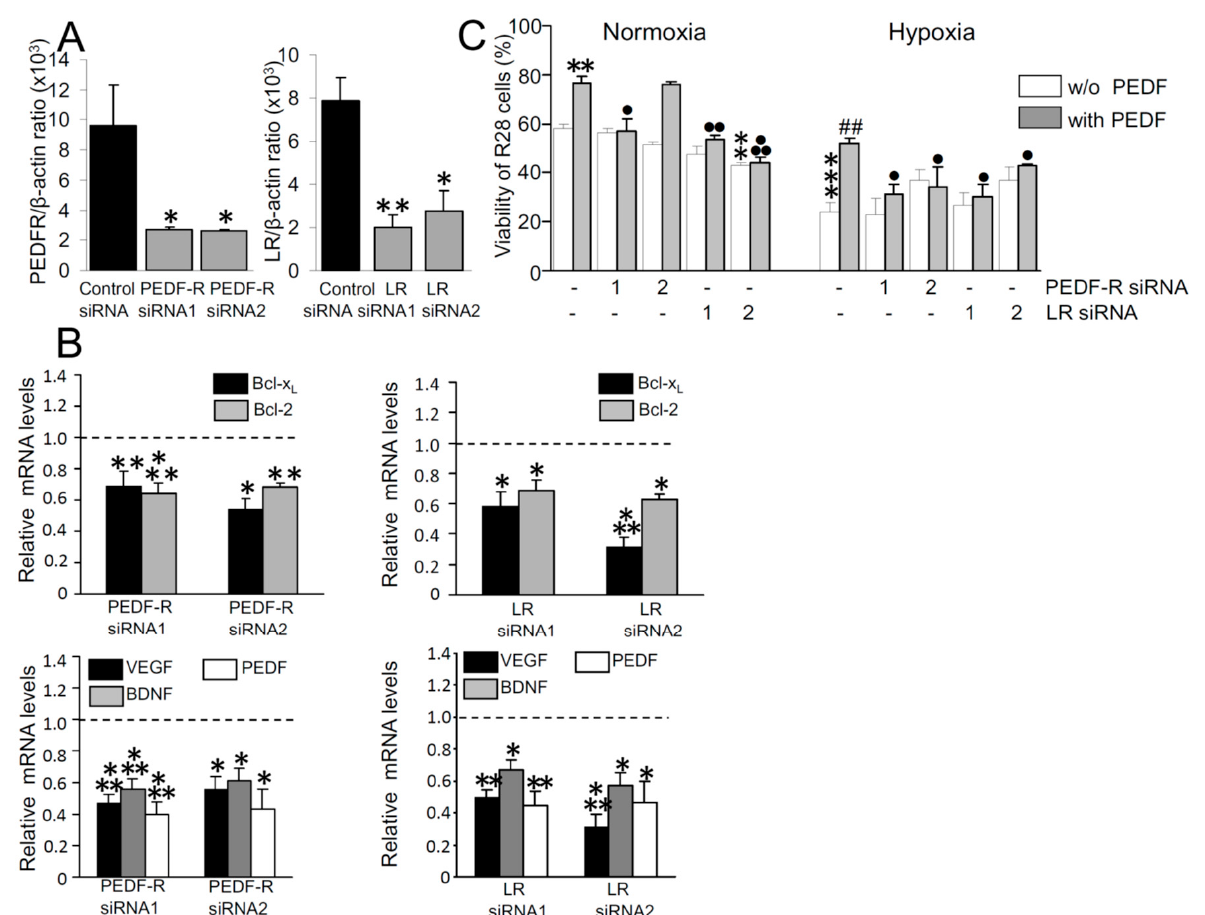
Figure 4. ( A ): Efficacy of PEDF-R and LR silencing induced by each of two different siRNAs in R28 cells. β -actin mRNA was used as endogenous reference transcript (means ± SEM; * p < 0.05, ** p < 0.01; n = 4). ( B ): PEDF-R and LR are involved in expression regulation of Bcl-2 family members ( upper panels) and neuroprotective secreted factors ( lower panels) in R28 cells. Cells transfected with the siRNAs indicated were cultured for 24 h and levels of Bcl-2, Bcl-x L , VEGF, PEDF and BDNF were analyzed by semi-quantitative real-time PCR (means ± SEM, n = 3–12, one sample t test vs. corresponding control siRNA-containing cultures ( dashed lines); * p < 0.05, ** p < 0.01, *** p < 0.001). ( C ): The viability of R28 cells was determined under normoxia and hypoxia under siRNA-mediated PEDF-R and LR knockdown and control (– –, control siRNA) conditions as well as in the presence or absence of PEDF. Significant differences to normoxic (** p < 0.01, *** p < 0.001) or hypoxic ( ## p < 0.01) PEDF-free control siRNA-containing, PEDF-free cultures and the significance comparing the effect of PEDF stimulation between control siRNA- and PEDF-R or LR siRNA-transfected cells ( • p < 0.05, •• p < 0.01, ••• p < 0.001) are indicated (means ± SEM; n = 3, one way